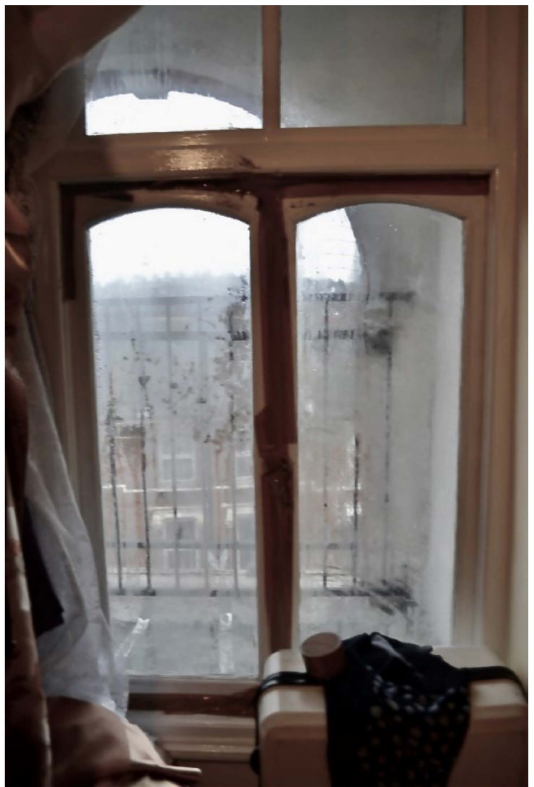
Figure 21. House